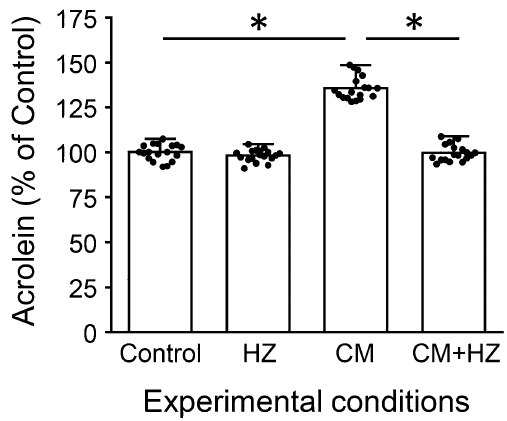
Figure 6. Isolating acrolein in post-impact diffusive secondary injuries. Culture medium from networks that experienced relatively large impact forces (200 g impacts rapidly administered 10x) was substituted in non-impact networks and incubated for 24 h. After incubation, ICC and subsequent intensity measurements were performed to evaluate acrolein-Lys adduct levels. This now “conditioned-medium,” or CM, allows for the separation of secondary from primary traumatic injury by removing the direct application of mechanical force from the procedure. Interestingly, CM network’s (non-impact networks exposed to treated media) average acrolein levels rose significantly. Further, the acrolein scavenger hydralazine was then introduced post conditioned media exposure at a concentration of 500 µM (CM + HZ). This resulted in a significant decrease of average acrolein production when compared with CM networks. Further, when these values were compared with non-impact controls (Control) and networks given identical concentrations of hydralazine with standard, non-conditioned medium (HZ), no significant changes were found. Staining intensity is shown as percent control values ± SD (n = 18). One-way ANOVA and subsequent Scheffe post hoc analysis were used to determine significance: *p < 0.01.